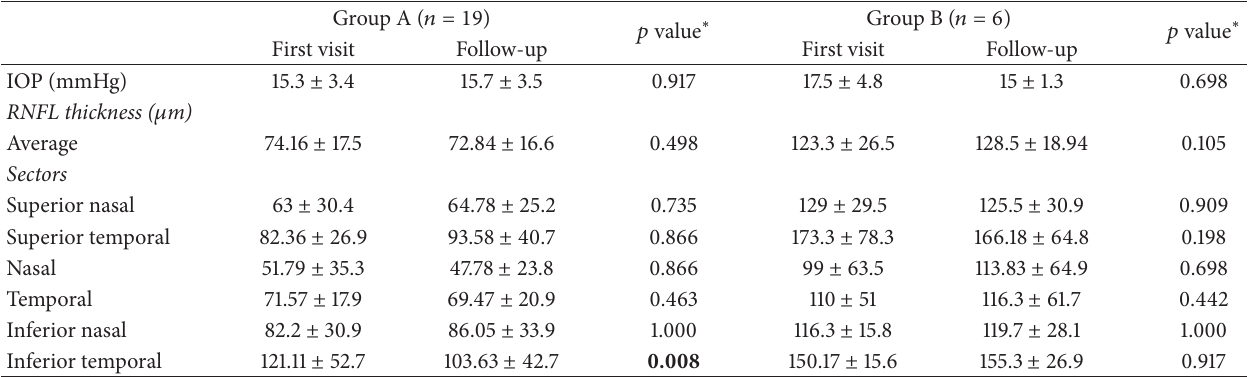
Table 3: RNFL thickness changes in retinoschisis